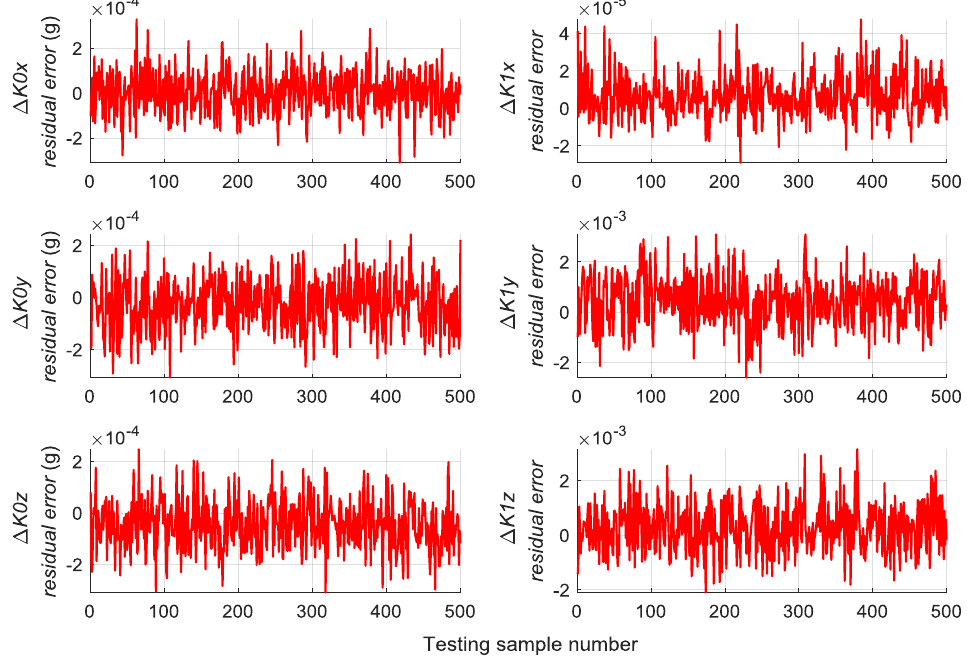
Figure 8. Simulation results of gyroscope residual error using RBM-BPNN method.